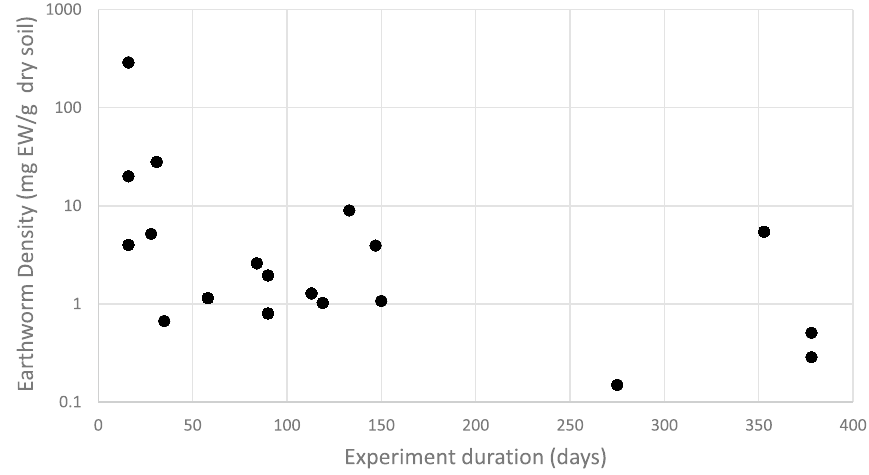
Figure 3. Earthworm density according to the duration of the experiments. The EW density distribution is as follows: Min: 0.15 mg EW/g dry, 1st quartile: EW density = 1.028 mg EW/g dry soil, 2nd quartile: EW